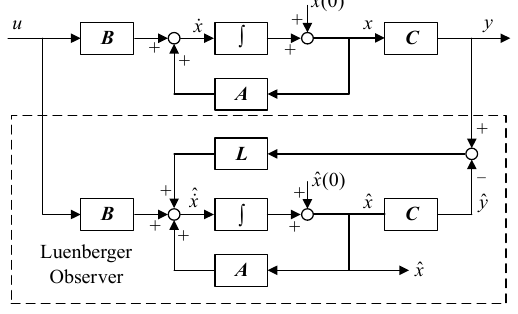
Figure 3. Structure diagram of the Luenberger observer.